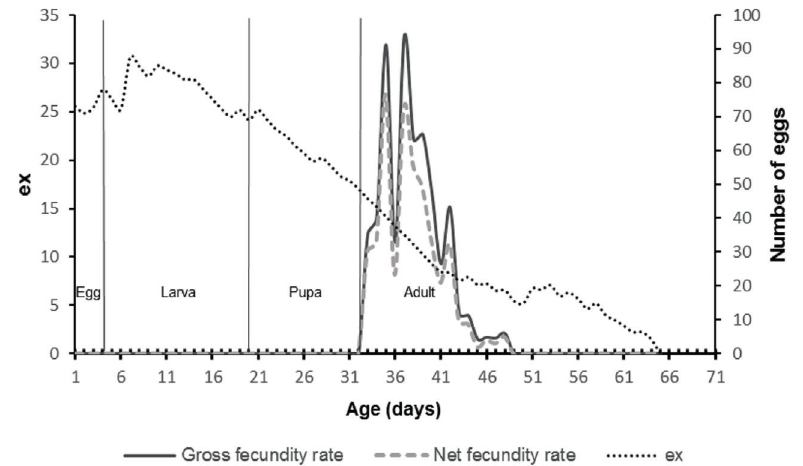
Figure 2 - Life expectancy (ex), daily gross and net fecundity of individuals of Helicoverpa gelotopoeon reared with artificial diet at 25 ± 2º C, 70-75% RH and